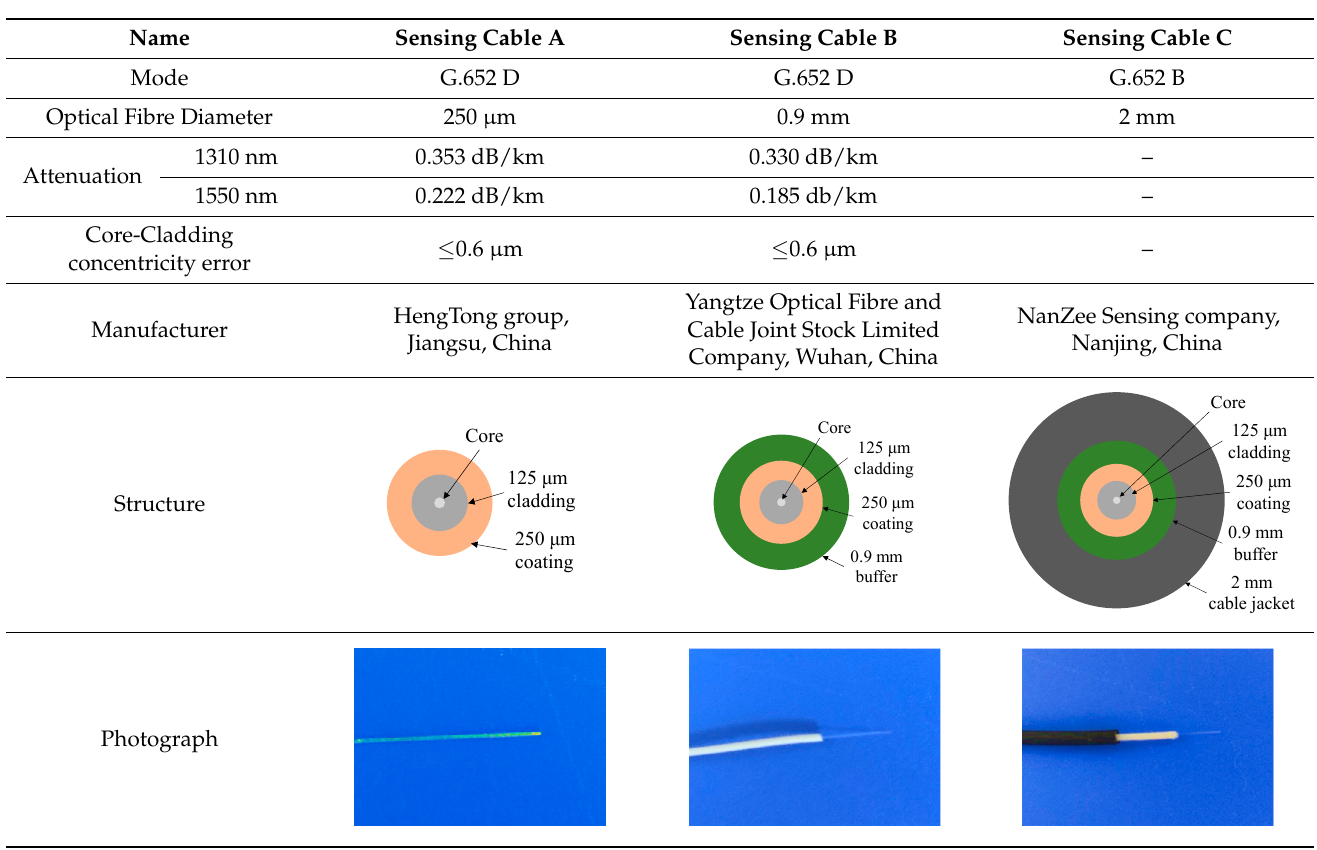
Table 2. Specifics for the three types of sensing cables.